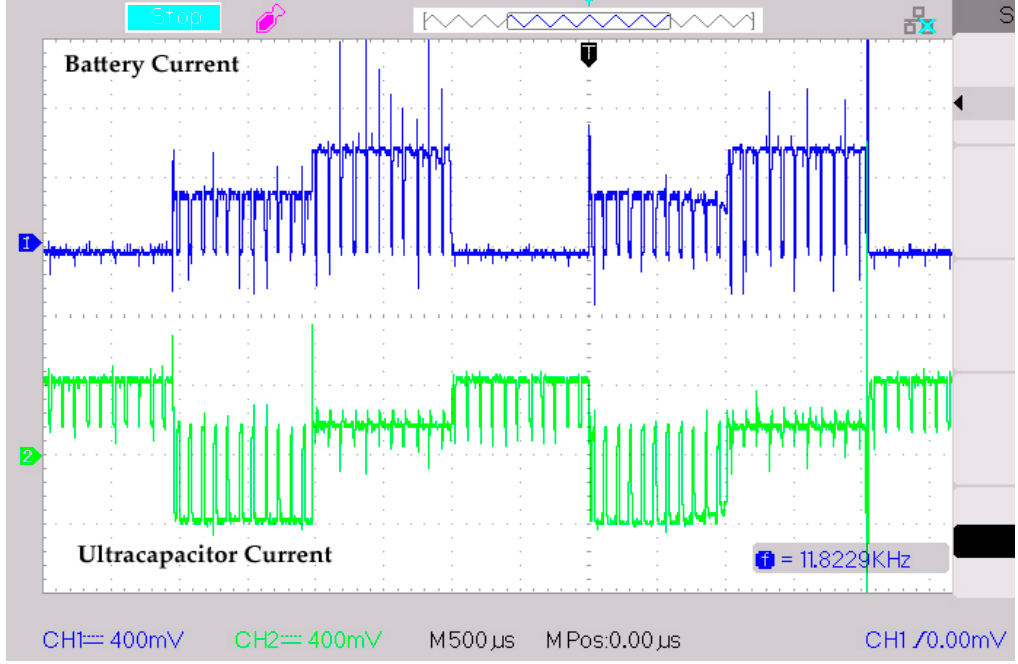
Figure 37. Battery and ultracapacitor currents, mode-3, mode-2, and mode-1 with t 1 = 0.5 ms, t 2 = 0.5 ms, t 3 =0.5 ms.